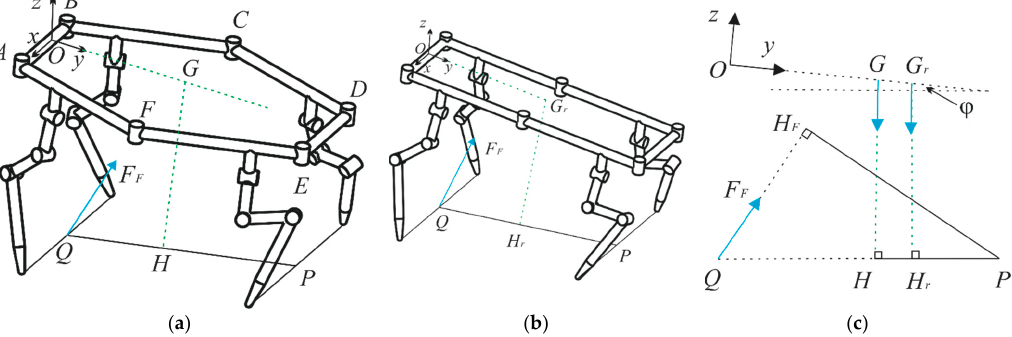
Figure 5. The torque and elevation angle analyses of the two robots. ( a ) The posture of the Origaker II at the beginning of jumping; ( b ) The posture of the rigid trunk robot at the beginning of jumping; ( c ) The sketch map of torques.